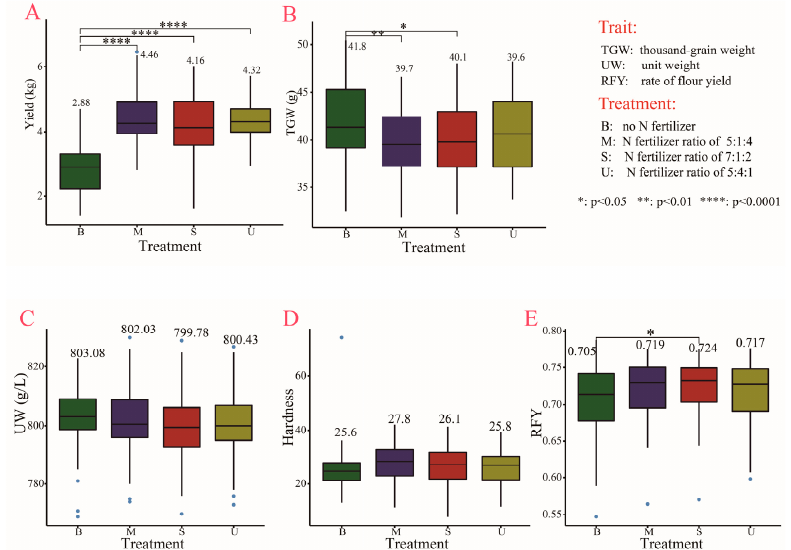
Figure 1. Yield- and grain-related traits under the four fertilizer treatments.( A – E ) Comparison of four fertilizer treatments in yield ( A ); thousand-grain weight ( B ); unit weight ( C ); hardness ( D ); and rate of flour yield ( E ). Box diagrams present the data in the inter-quartile ranges. The lines across the boxes, whiskers, and blue circles denote the median values, the 10th and 90th percentiles and outliers, respectively.